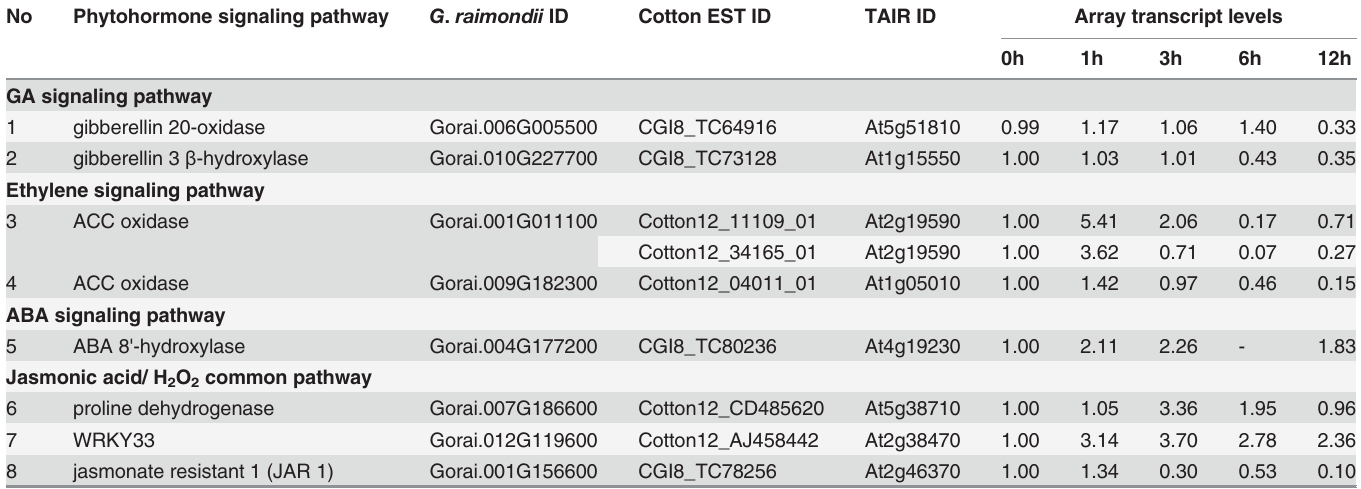
Table 2. Phytohormonal pathways regulated in pre-anthesis cotton ovules (-1 DPA) by auxin and GA.